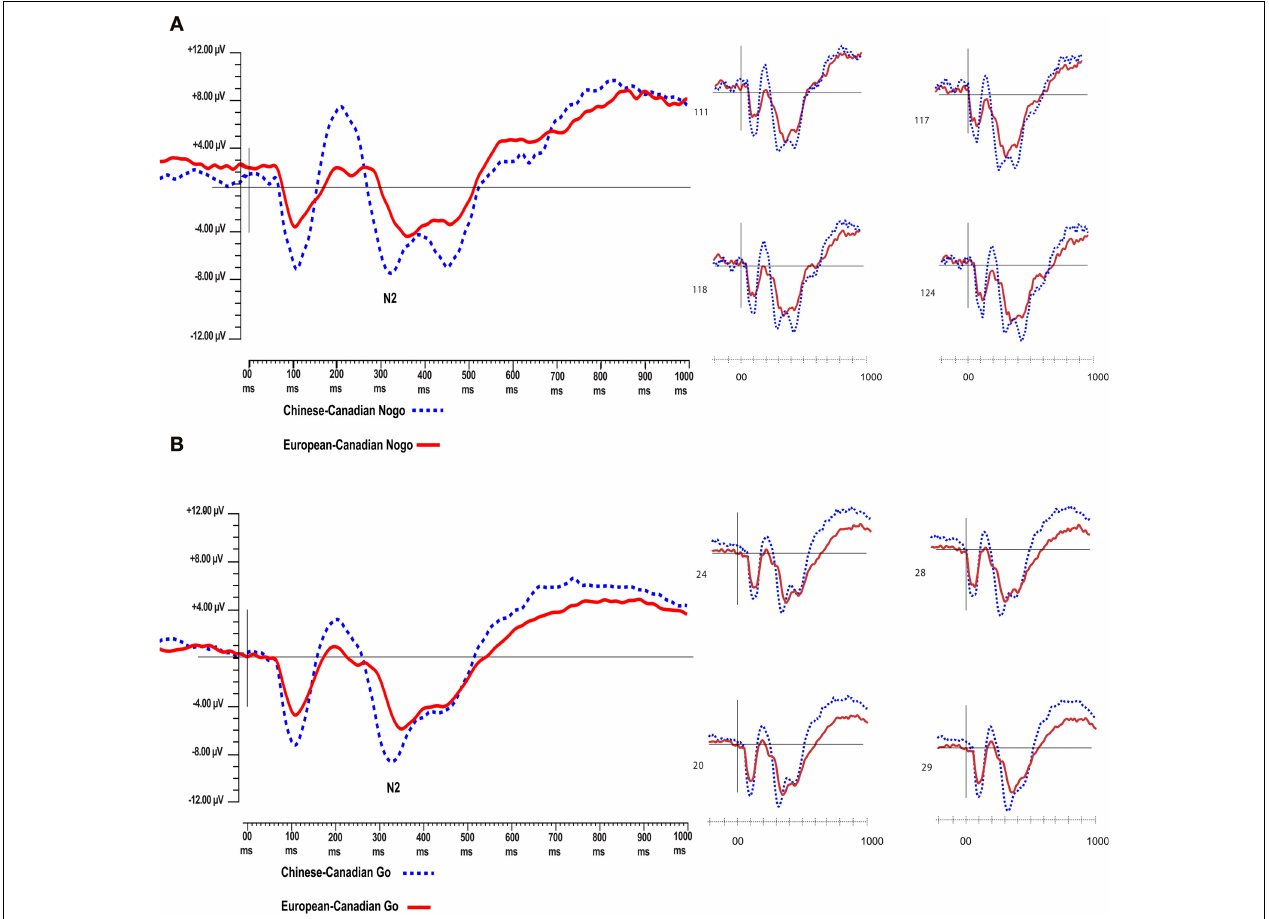
FIGURE 3 | Stimulus-locked grand-averaged ERP waveforms for the two cultural groups. (A) Data from fronto-central electrode site 112 (right-hemisphere) for the no-go condition, accompanied by waveforms from electrode sites 111, 117,